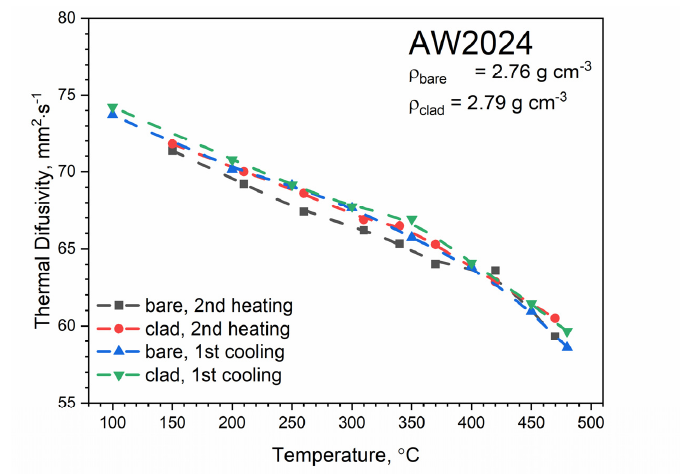
Figure 12. Thermal diffusivity as a function of temperature for bare and clad AW-2024-T3 alloys obtained from the first and second heating and first cooling runs on LFA 467.